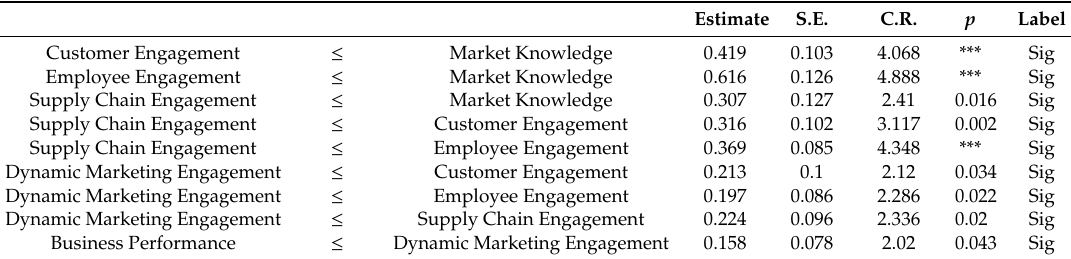
Table 2. Hypothesis